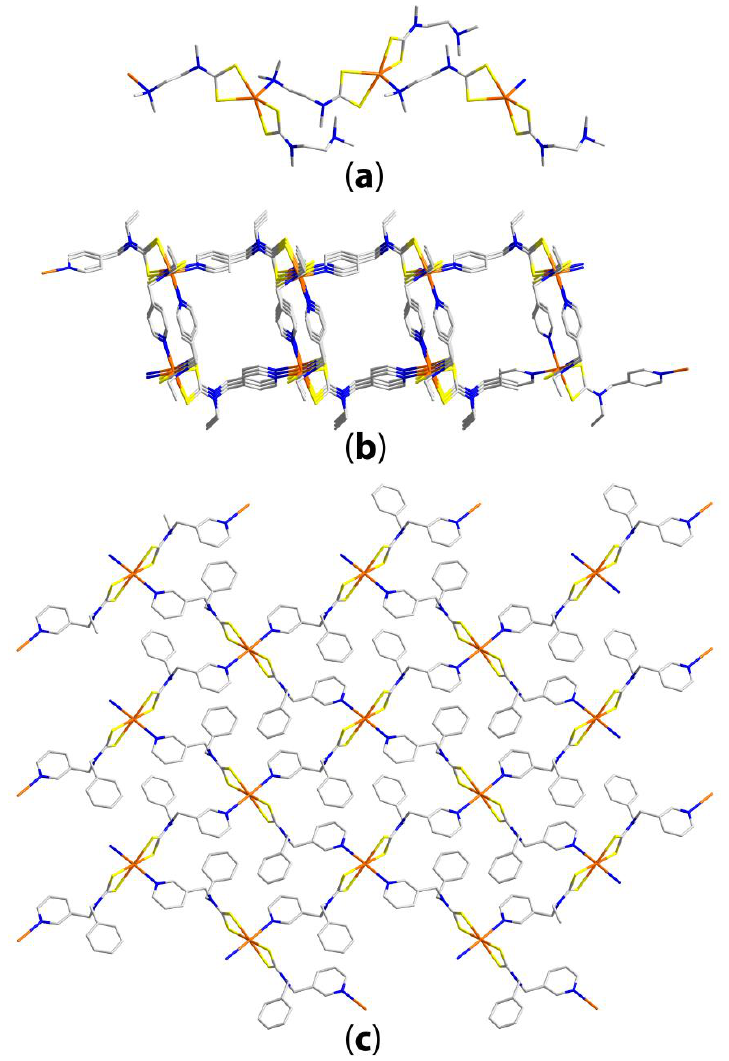
Figure 12. Images of ( a ) one-dimensional {Cd[S 2 CN(Me)(CH 2 ) 2 NMe 2 ] 2 } n ( 128 ); ( b ) the double-layer in {Cd[S 2 CN(Et)CH 2 (3-py)] 2 } n ( 129 ); and ( c ) two-dimensional {Cd[S 2 CN(Benzyl)CH 2 (3-py)] 2 } n ( 130